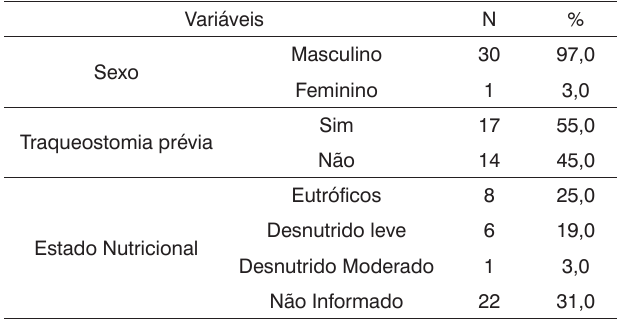
Tabela 1. Características clínicas dos pacientes (n =